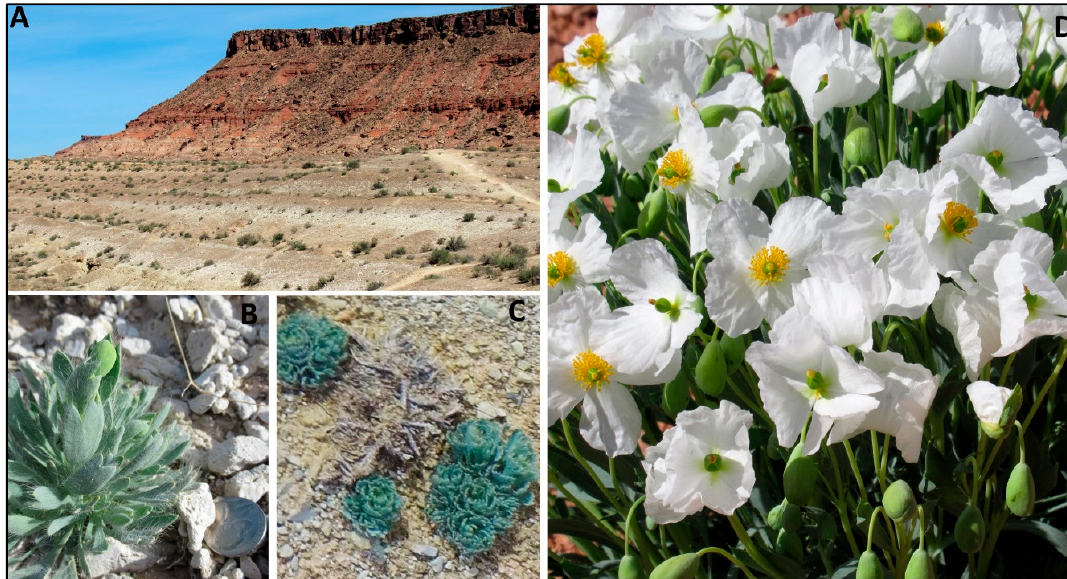
Figure 2. ( A ) Example of high-density dwarf bear-poppy habitat, with poppies clustered primarily within and around the peripheries of white shale bands; ( B ) a yearling dwarf bear-poppy (~8 cm) with developing inflorescence; ( C ) typical dwarf bear-poppies, as seen from 5-m altitude drone imagery, showing blue-green color and mound shape; ( D ) dwarf bear-poppy in full flower.